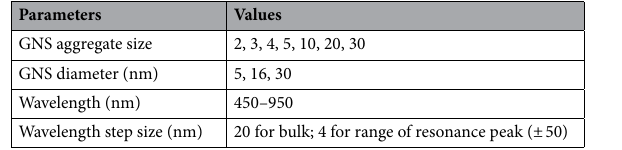
Table 2. DDA simulation matrix of aggregated